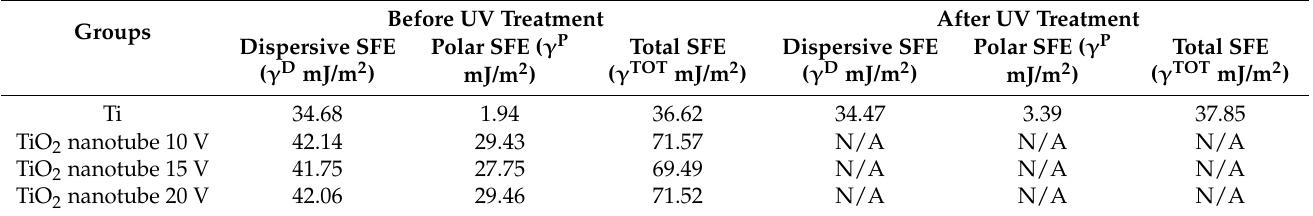
Table 5. Mean values (mJ/m 2 ) of surface free energy (SFE) components calculated using the Owens– Wendt approach.